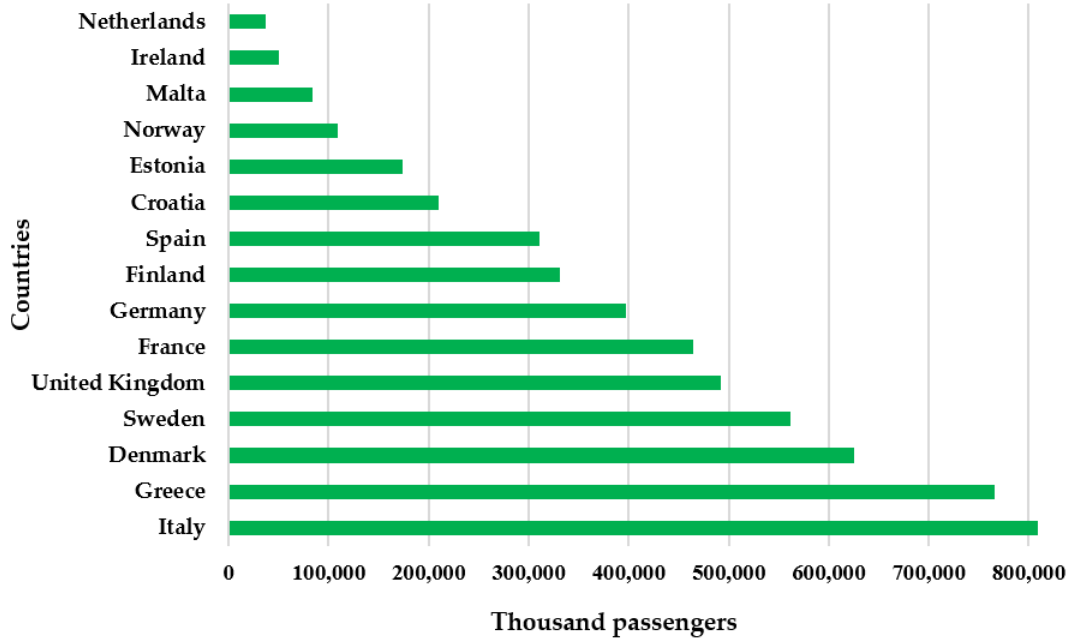
Figure 8. Top 15 countries of European countries regarding the number of passengers for the period 2001 – 2020.